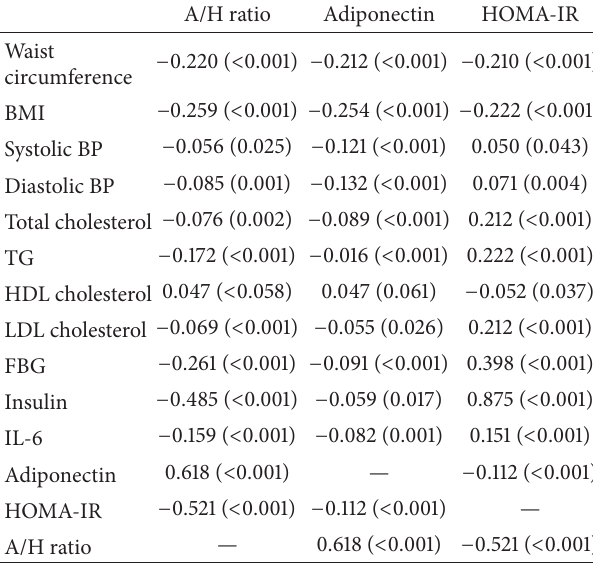
Table 3: Odds ratios and 95% confidence intervals for the associa- tion between metabolic syndrome and various